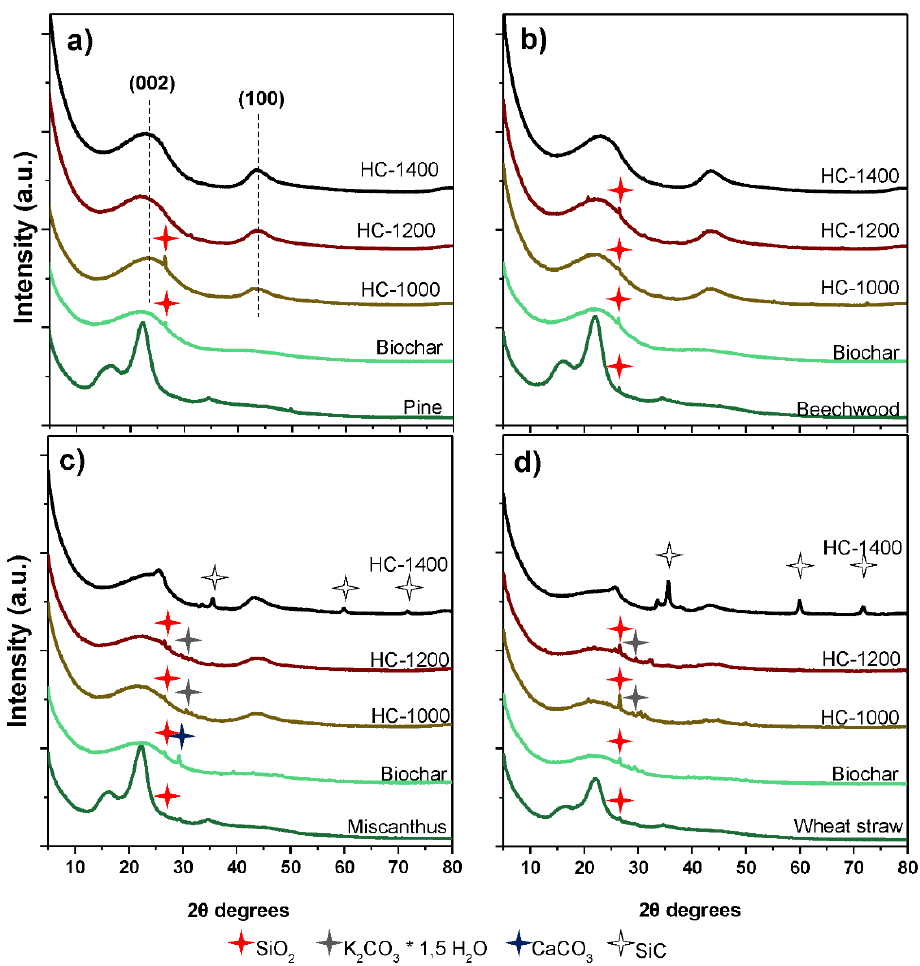
Figure 3. XRD patterns for ( a ) pine, ( b ) beechwood, ( c ) miscanthus and ( d ) wheat straw, for the initial biomass precursor, the intermediate biochar and the three final hard carbons obtained at 1000, 1200 and 1400 °C.